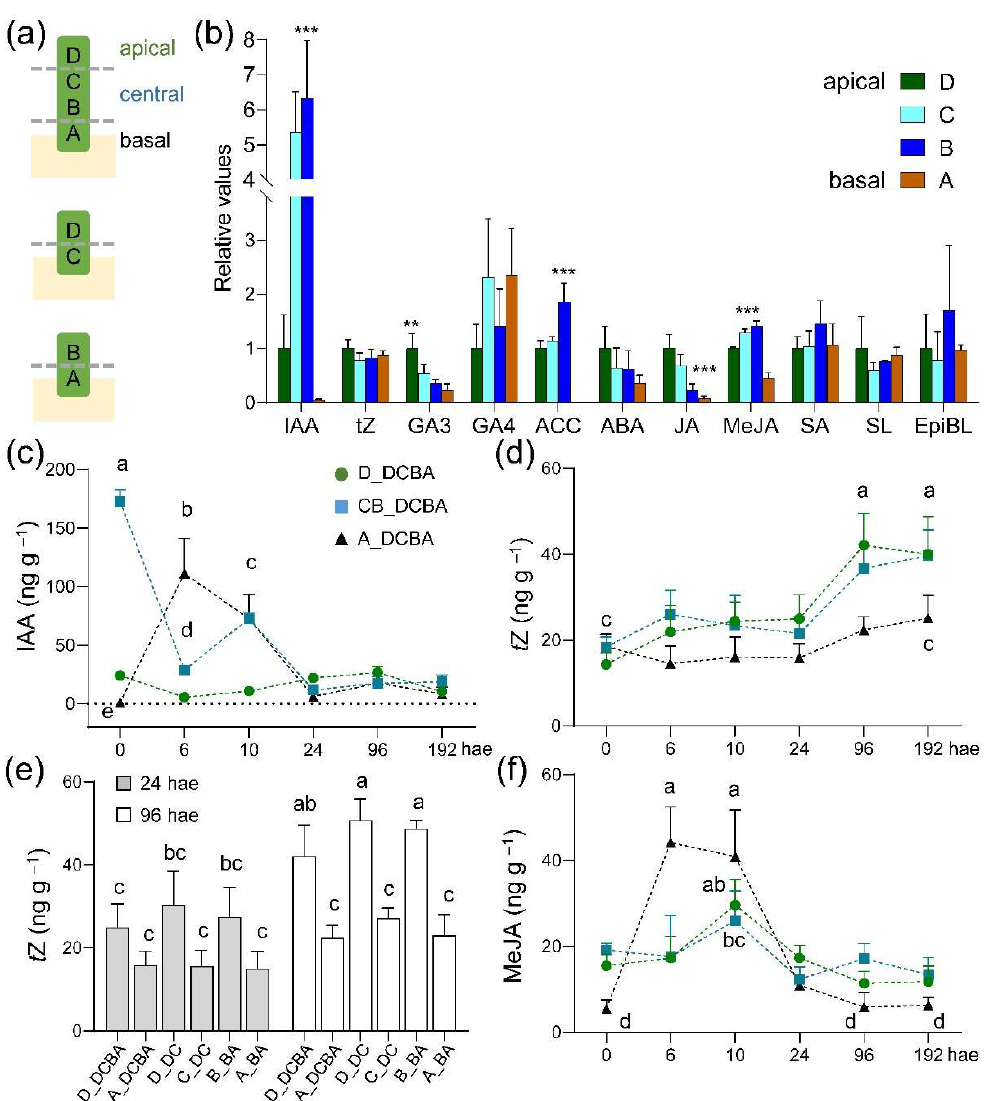
Figure 2. Endogenous hormone levels during de novo organ formation. ( a ) Diagrams showing the hypocotyl fragments used in the different experiments, with dashed lines indicating the regions assayed for hormone levels. ( b ) Relative endogenous levels of several hormones at 0 hae as regards to those in the apical region of the hypocotyl explants; asterisks indicate significant differences ( p -value < 0.05 *, 0.01 **, or 0.001 ***) between the studied regions (D, C, B, and A) in whole hypocotyl explants (DCBA fragments). ( c – f ) Endogenous levels of indole-3-acetic acid (IAA; c), trans -zeatin ( t Z; d-e), and methyl jasmonate (MeJA; f) during the studied time course. ( e ) Endogenous levels of t Z at 24 and 96 hae in apical (D) and basal (A) regions of whole (DCBA) or half-sectioned (DC and BA) hypocotyl explants. Different letters in c-f indicate significant differences ( p -value < 0.01) between the studied samples.